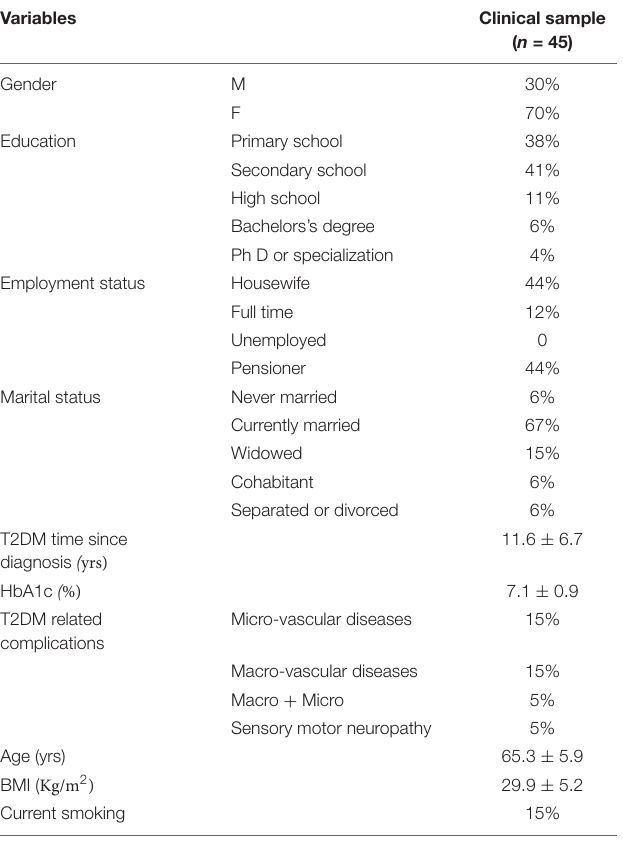
Neither anxiety nor depression were associated with